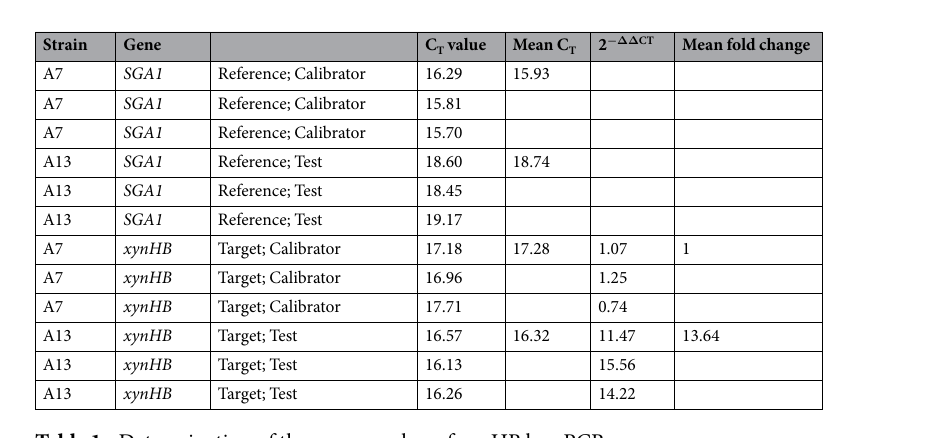
Table 1. Determination of the copy number of xyn HB by